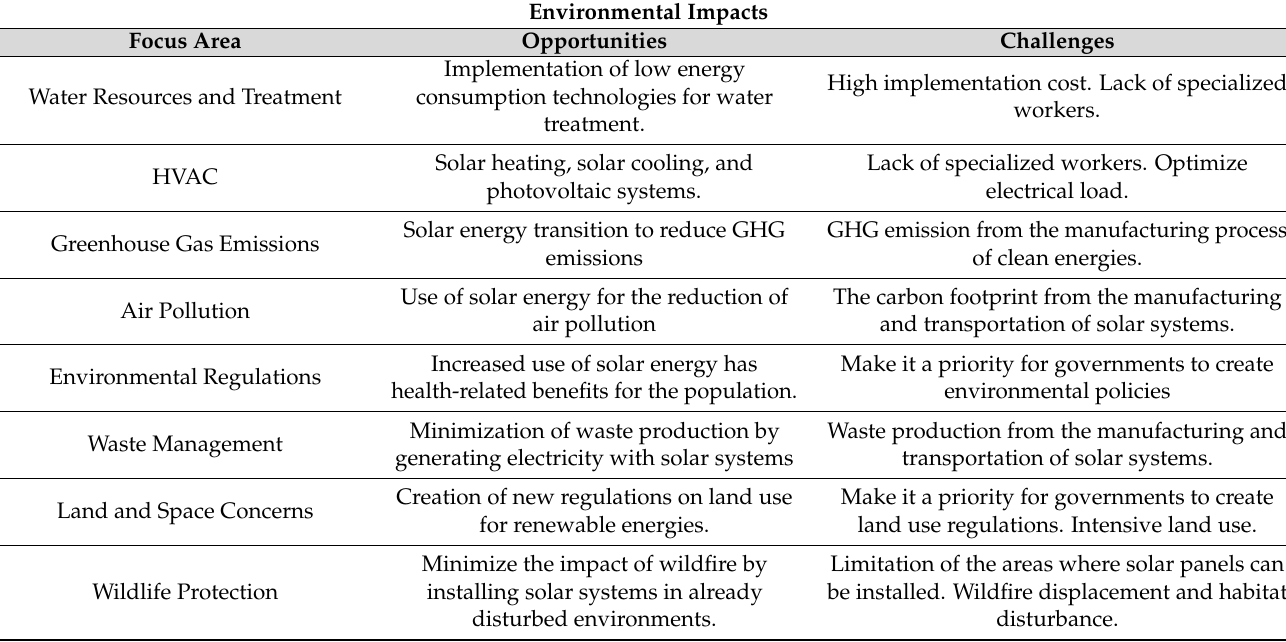
Table 2. Summary of opportunities and challenges for the use of solar energy in health facilities— environmental